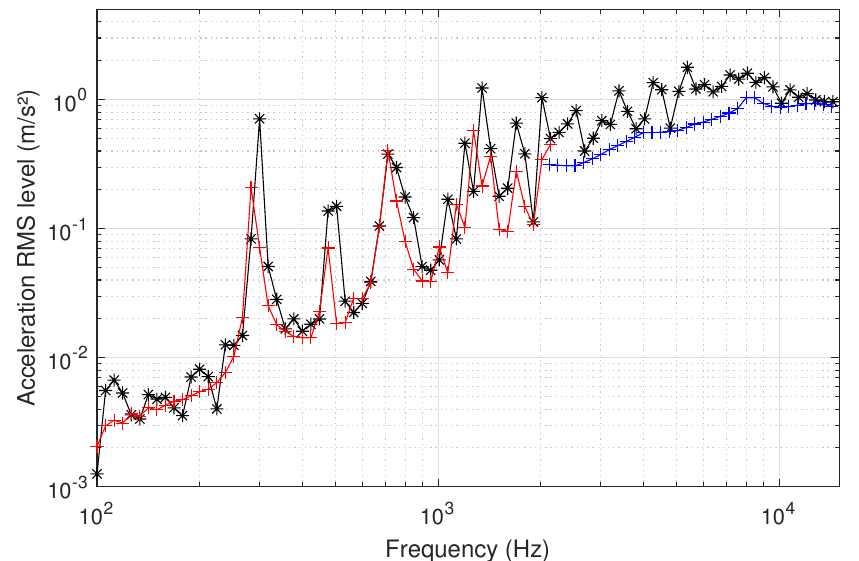
Figure 20. Full-frequency test–simulation comparison at point (a), one-twelfth-octave frequency band representation. The experimental response (black curve with stars) is compared with the combination of the FE-BEM results (red curve with +) and SEA results (blue curve with